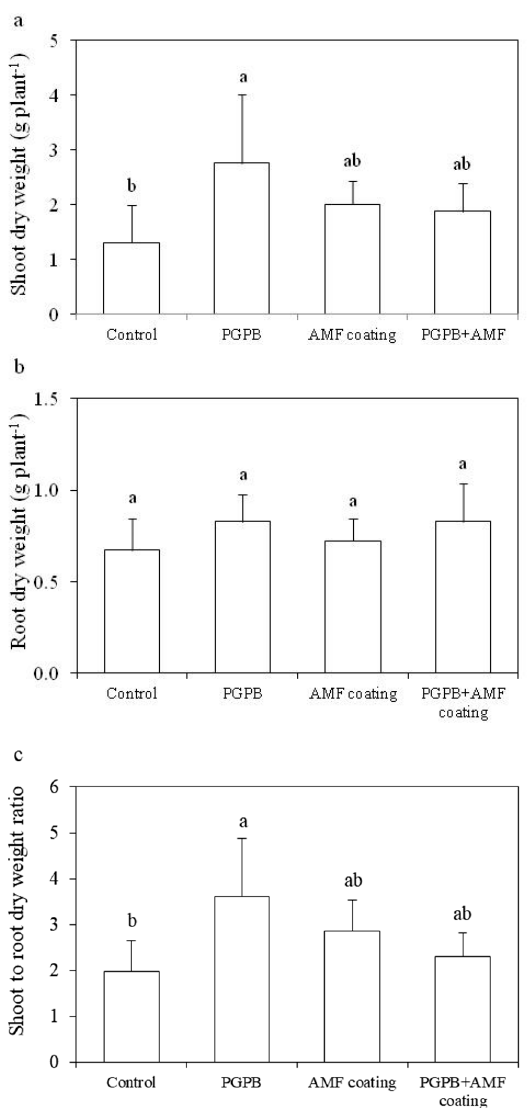
Figure 2. Effects of individual and combined inoculation of PGPB and AMF on shoot ( a ) and root ( b ) dry weight, and shoot to root dry weight ratio ( c ). Error bars represent standard deviation. Data of columns indexed by the same letter are not significantly different according to Tukey ′ s Honestly Significant Difference (HSD) test ( p < 0.05).